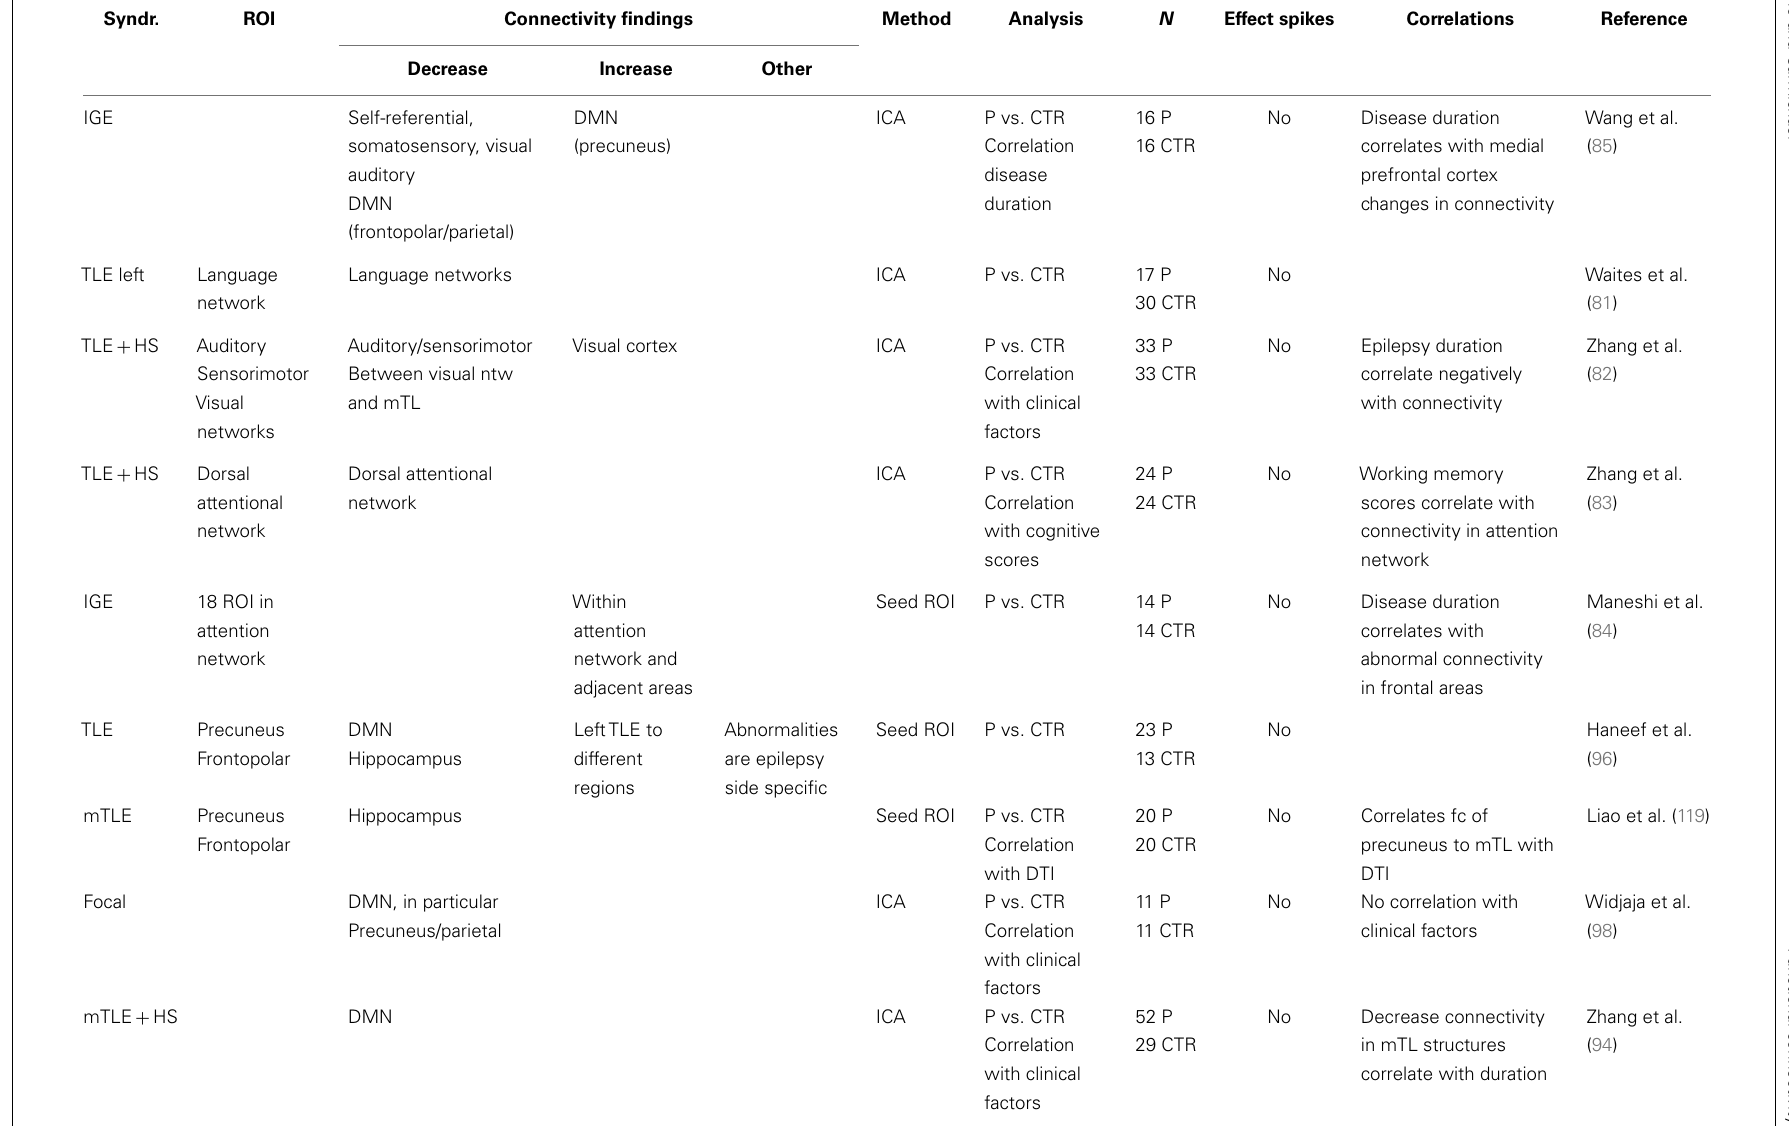
Table 2 | Resting state studies in epilepsy reporting abnormalities of cognitive networks .